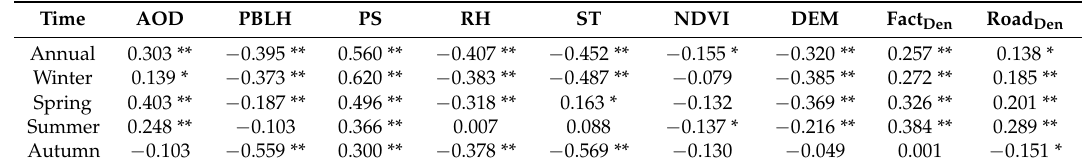
Table 2. Annual and Seasonal Pearson Correlation Coefficients between PM 2.5 and other covariates.